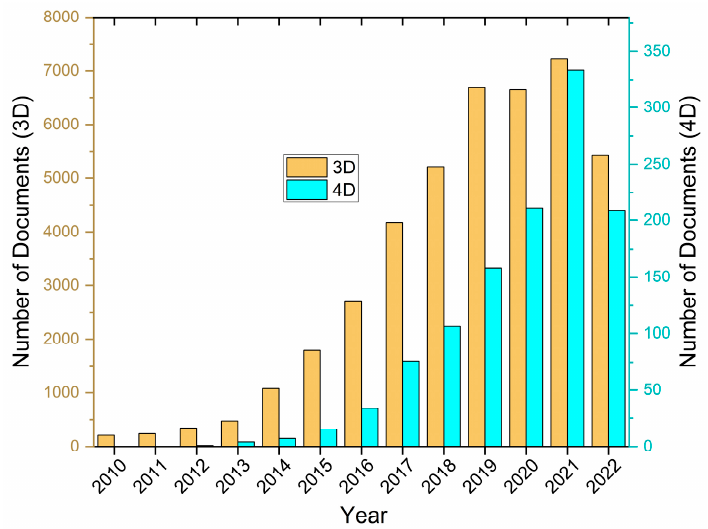
Figure 2. Research published on 3D and 4D printing, in the form of articles, reviews, patents, and conference papers per year as of September 2022. Data extracted from the web of science database. The keywords “additive manufacturing” and/or “3D printing” and “4D printing” were used for exact title search for 3D and 4D printing document search, respectively.